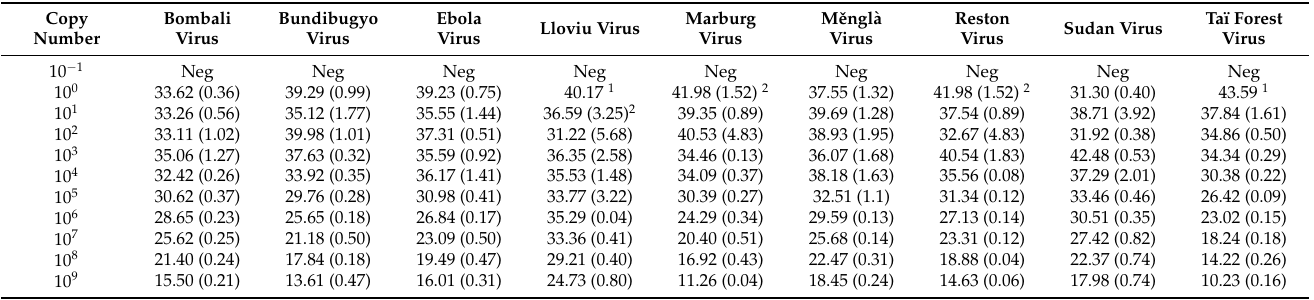
Table 4. The average SYBR Green Cq values (standard deviation, SD) for serially diluted standard templates tested in triplicate.